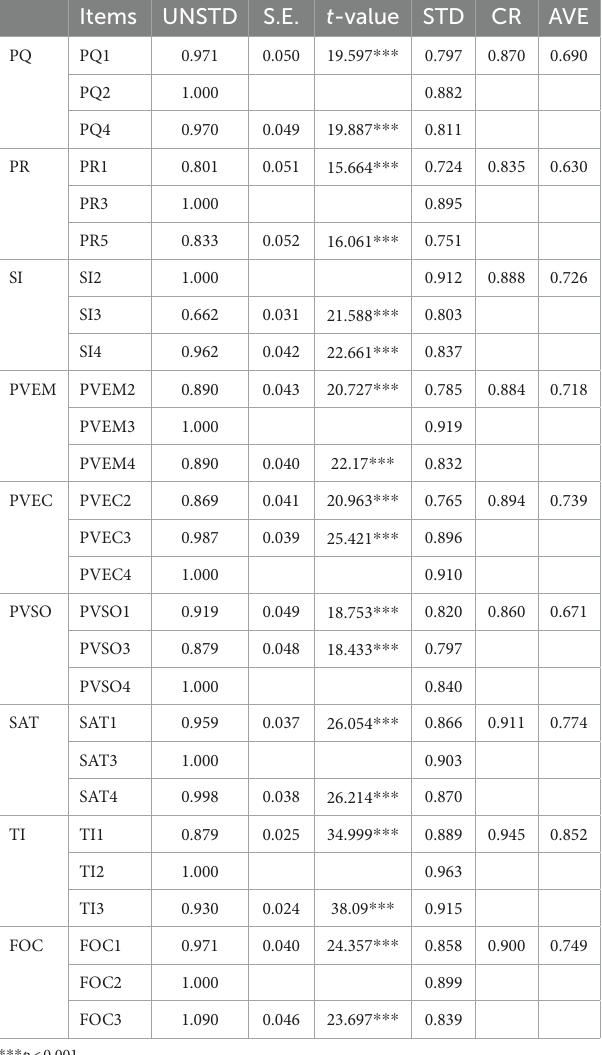
TABLE 2 Results of confirmatory factor